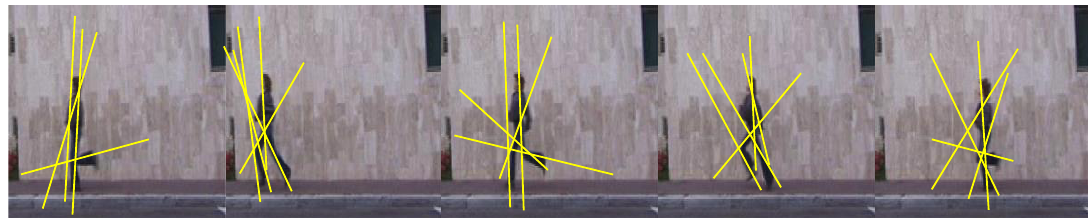
Figure 4. An example of straight-line detection in a video sequence of running